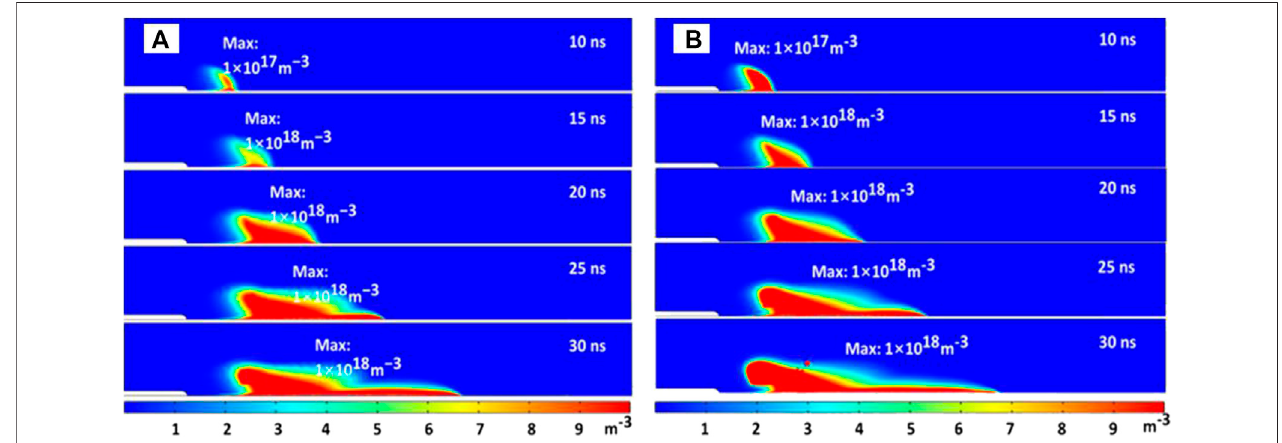
FIGURE 8 | The spatiotemporal evolution of N 4+ density with uniform permittivity (A) and graded permittivity (B) dielectric barrier.